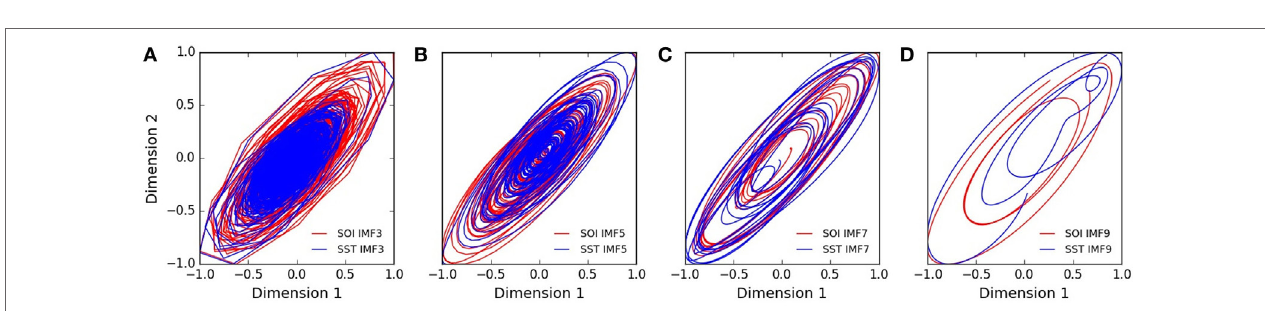
FigUre 2 | Monocomponents of southern oscillation (SOI) and sea surface temperature (SST). (a–D) show intrinsic mode functions of southern oscillation, which are the oscillatory components with different time scales. (e–h) show intrinsic mode functions of sea surface temperature, which are the oscillatory components with different time scales. The timescales of IMF 3 is one year, but 172 years for IMF 10 .